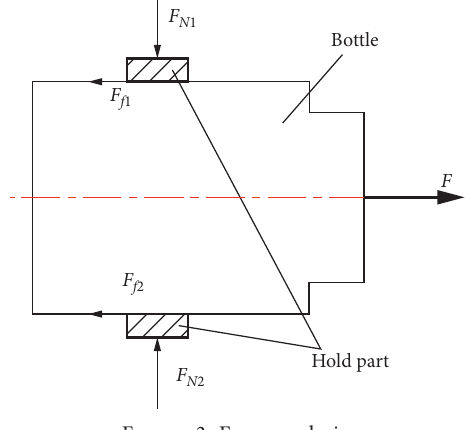
Figure 3: Force analysis.